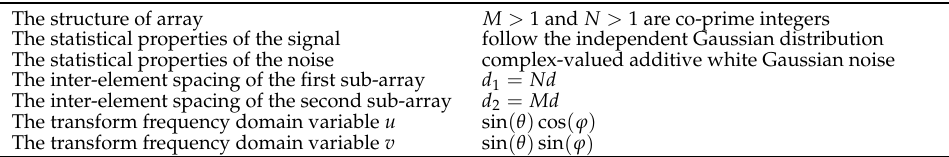
Table 1. The main assumptions of the signal